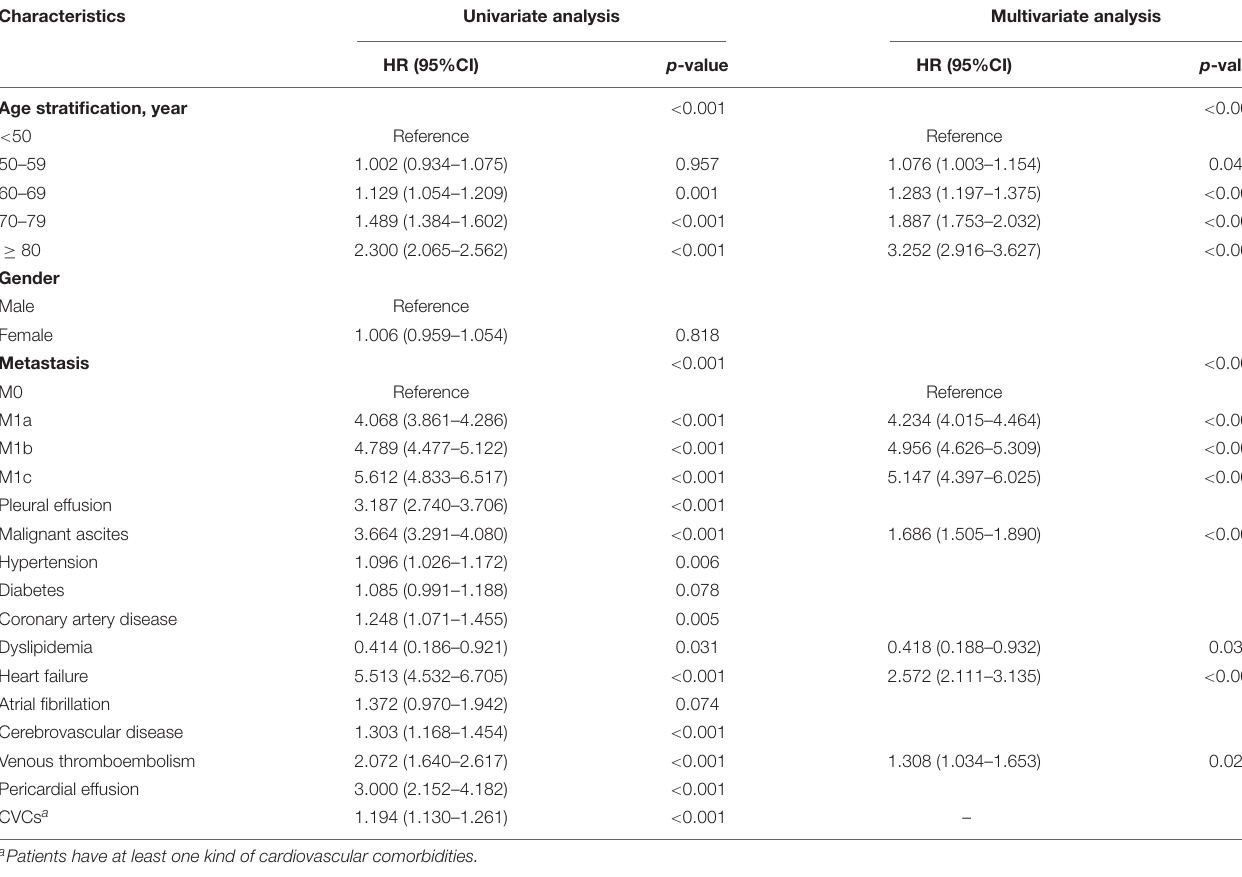
TABLE 2 | Univariate and multivariate cox regression analysis between characteristics and overall survival (OS). Characteristics